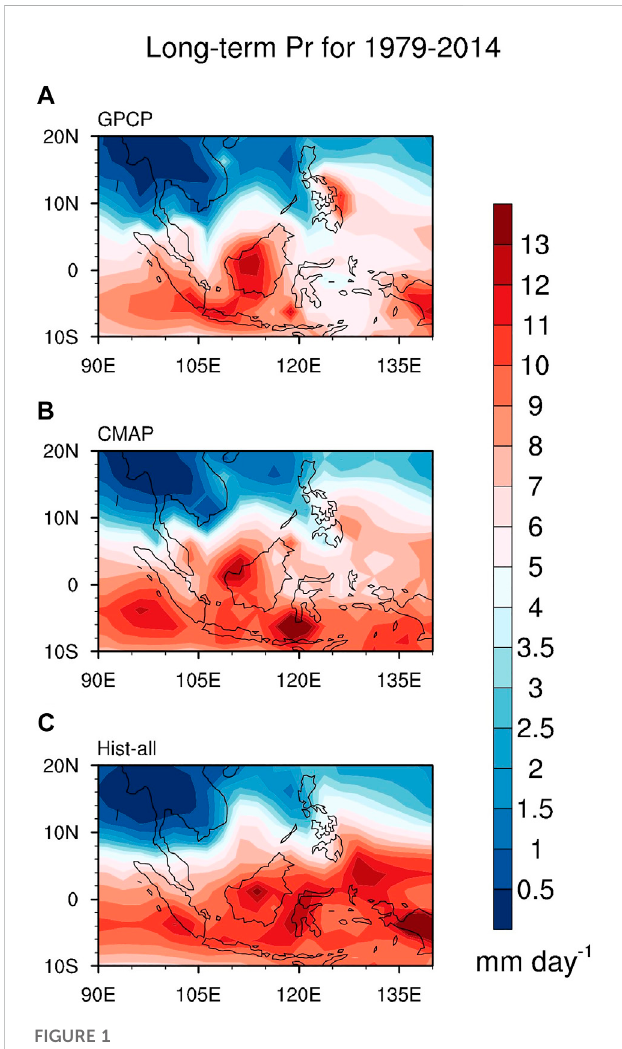
FIGURE 1 Spatial distribution of climatological mean winter precipitation (shadding, unit: mm day − 1 ) over Southeast Asia during 1979 – 2014 in (A) GPCP, (B) CMAP, and (C) Hist-all MME, respectively.